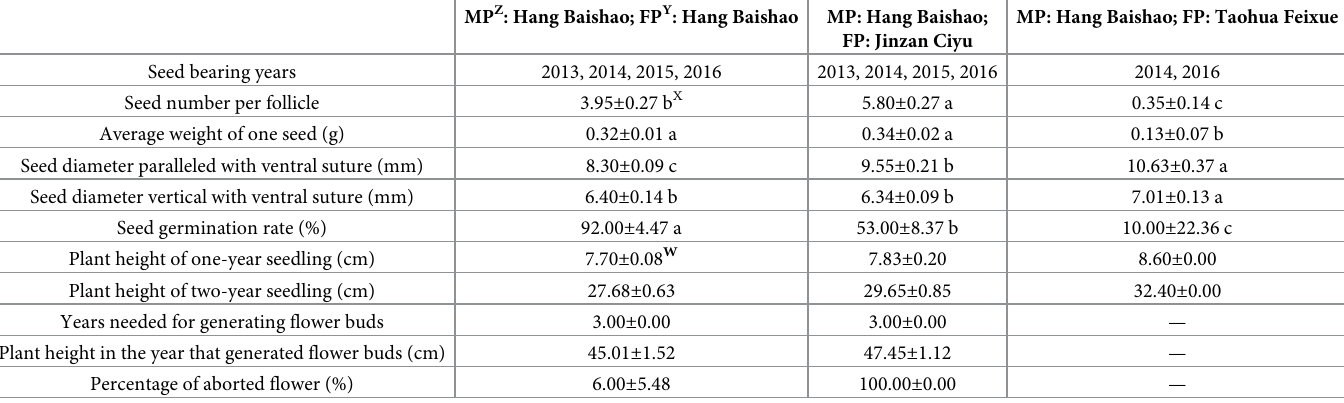
Table 6. Statistics of the hybridization among the three cultivars from 2013 to 2016.